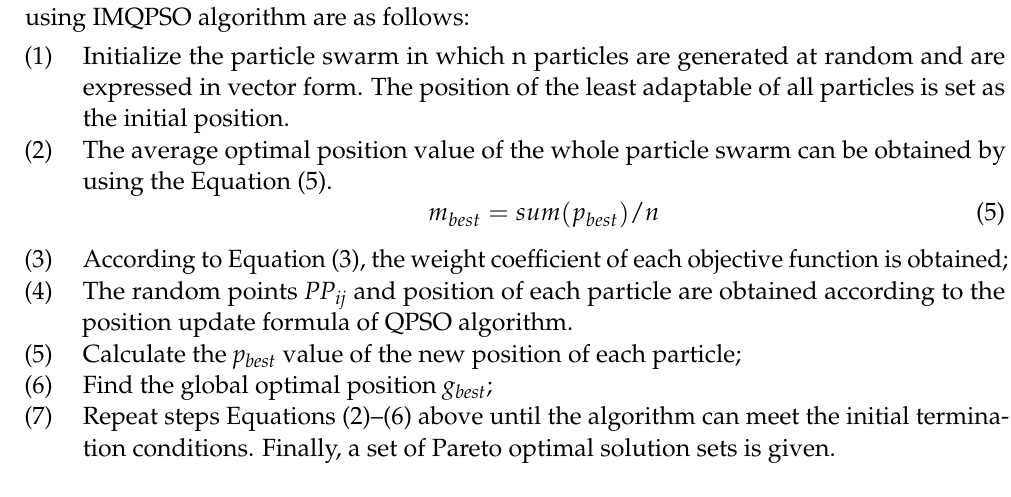
Figure 6. The convergence curve of the average value of the function before and after the improvement of inertia weight: ( a ) before improving; ( b ) after improving.